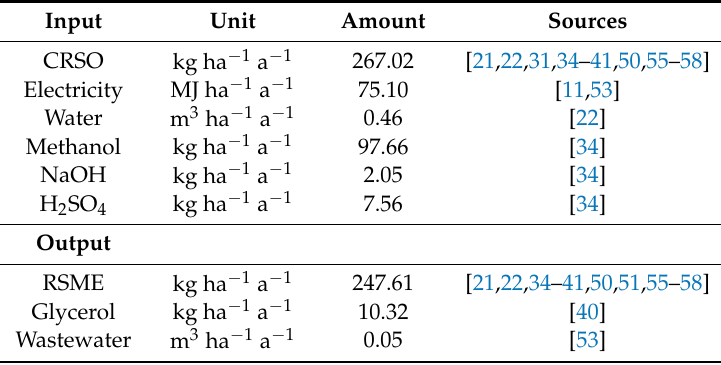
Table 4. Inputs and outputs of rubber seed oil transesterification